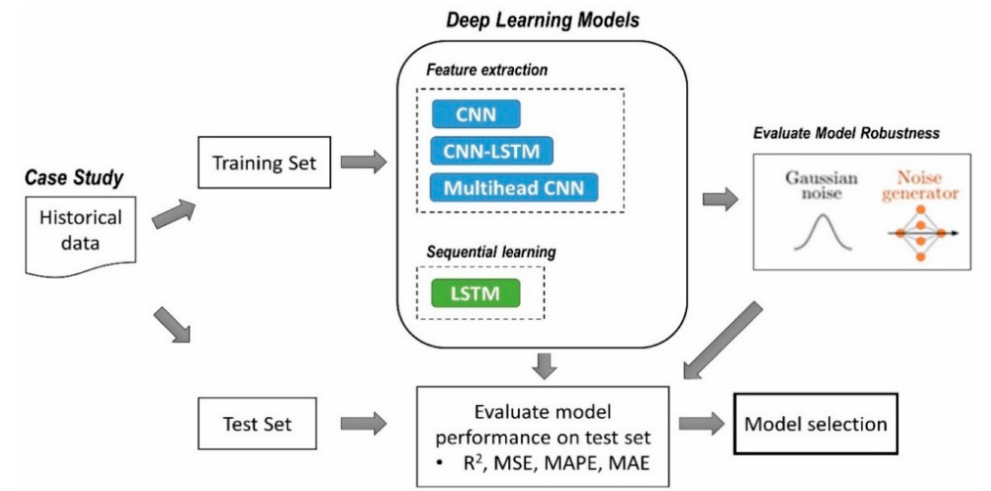
Figure 1. Deep learning framework proposed for forecasting peak